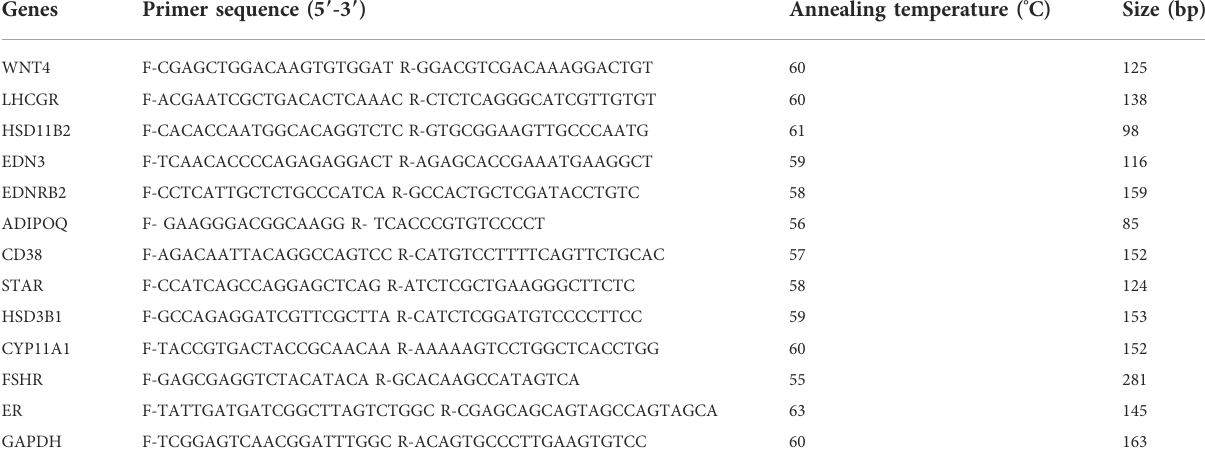
TABLE 1 The primers used to detect the targeted genes by